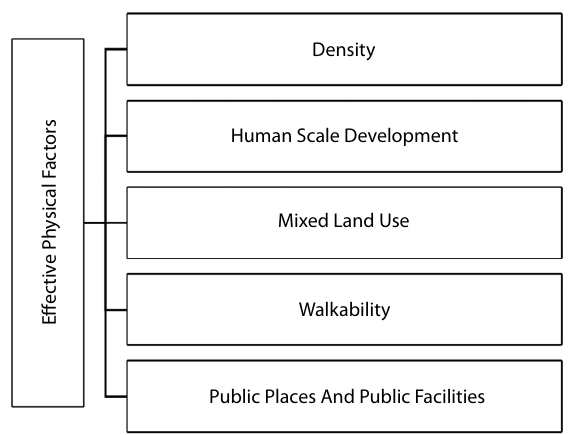
fig. 2. Effective physical factors in terms of the social life in historic neighbourhoods of Shiraz